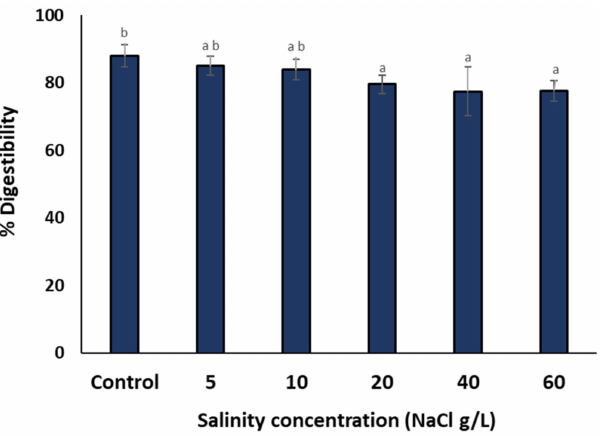
Figure 6. Protein in vitro digestibility of A. platensis cultivated at different salinities. The data represent the mean of n = 3, error bars: standard deviation. The different letters denote statistically significant